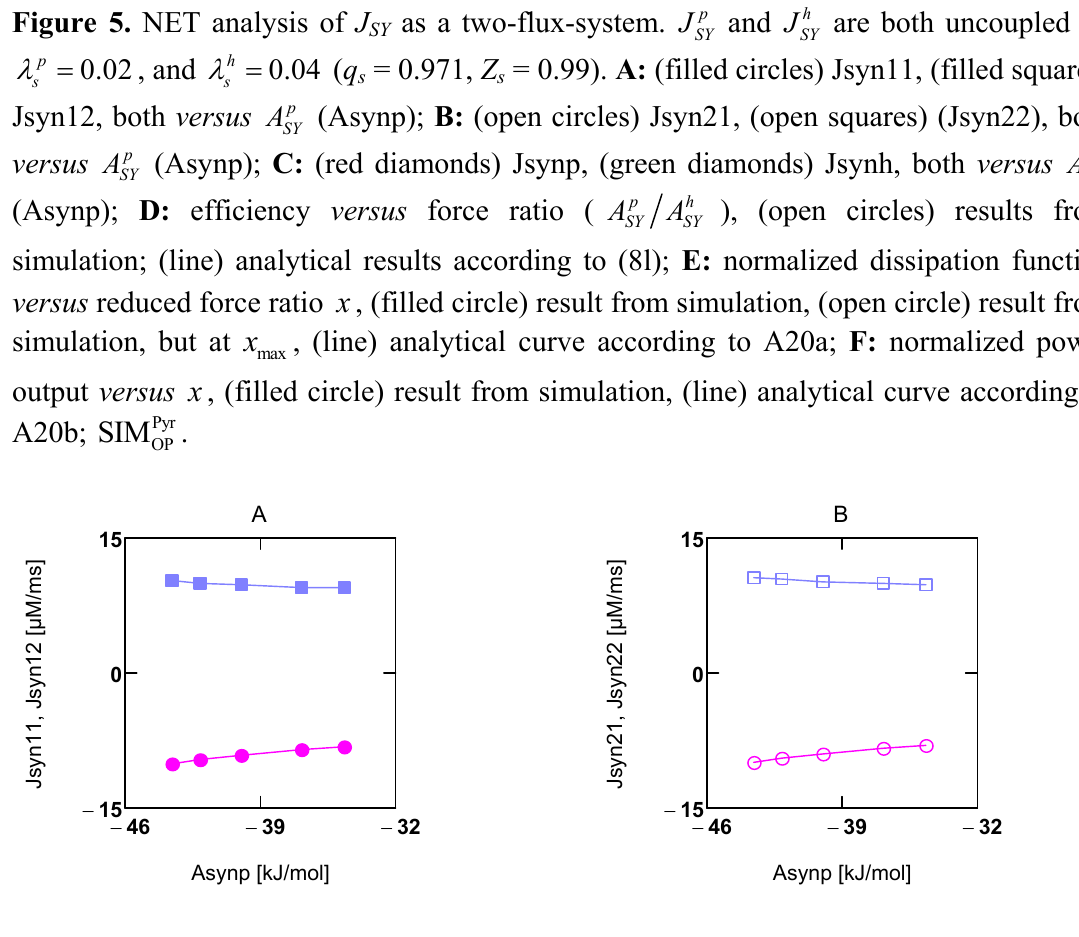
Figure 5. NET analysis of J